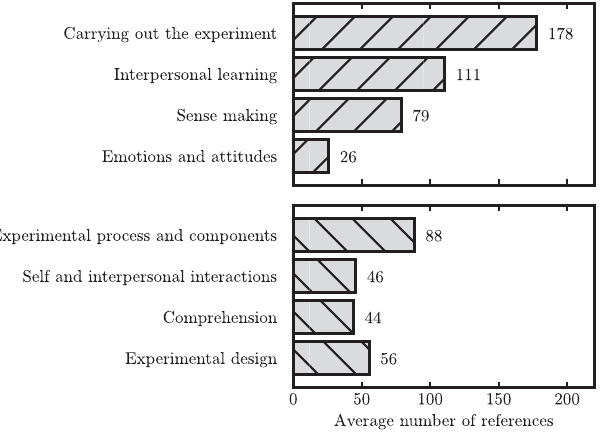
FIG. 1. Histograms depicting the frequency of the themes in each experiment. Shown are the average number of references in each theme in the guided-inquiry experiment (top) and in the open-inquiry experiment (bottom). The frequency is calculated by dividing the total number of references in each theme by the number of the corresponding data sets in the guided-inquiry (5 data sets) or open-inquiry experiment (8 data